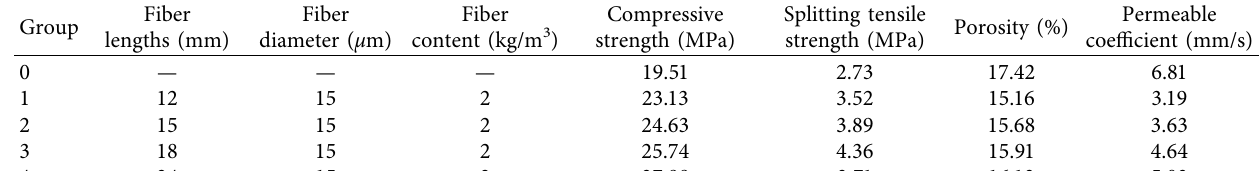
Table 5: Test results of pervious concrete with diferent basalt fber lengths.